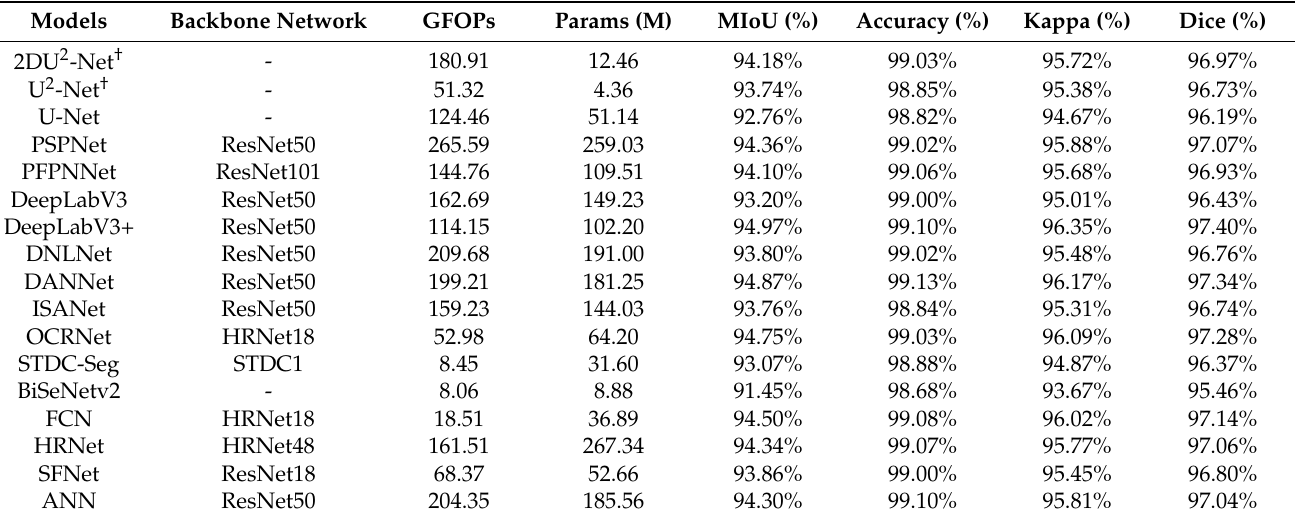
Table 1. Network model test